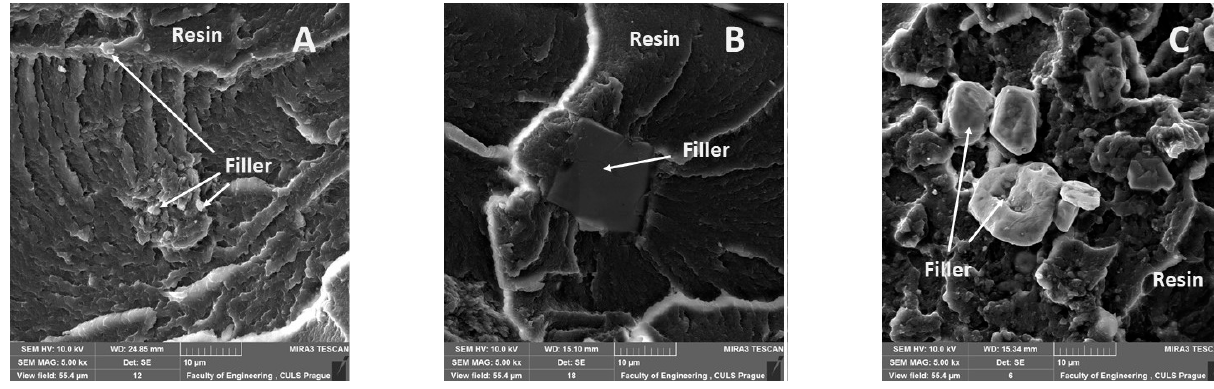
Figure 15. SEM images of fracture surface with filler montmorillonite (NanoBent ZR2), (MAG 5.00 k×): ( A ) mixing speed— 460 rpm, ( B ) mixing speed—1700 rpm, ( C ) mixing speed—2500 rpm.